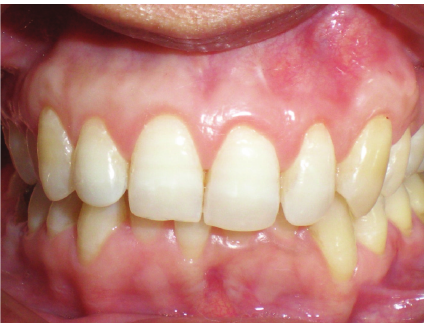
Figure 5: One year